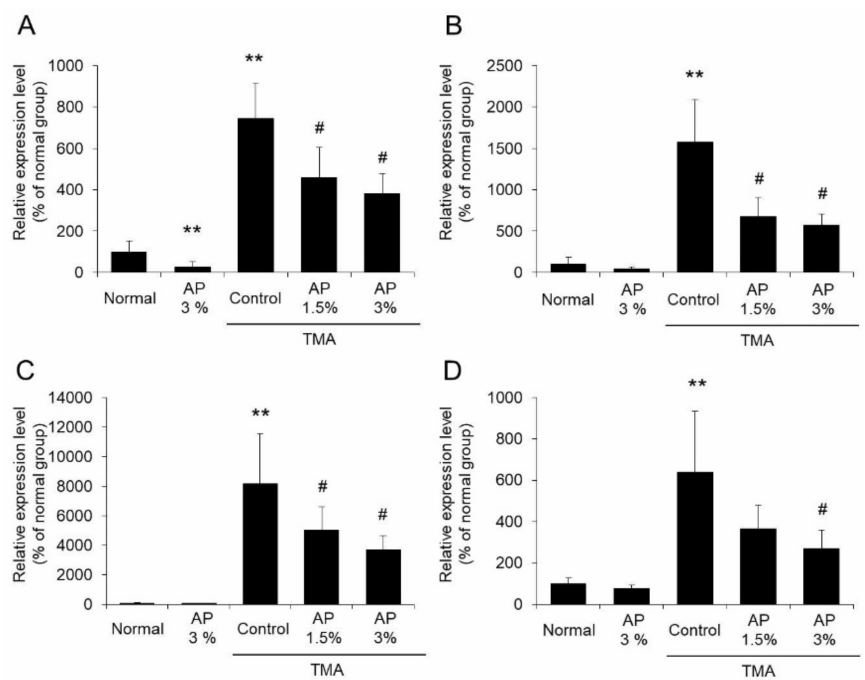
Figure 4. The mRNA expression levels of TNF- α ( A ), IL-6 ( B ), iNOS ( C ), and COX-2 ( D ). Mice with atopic dermatitis induced by repeated application of TMA were given a diet with AP. The skin was harvested, and the TNF- α ( A ), IL-6 ( B ), iNOS ( C ), and COX-2 ( D ) mRNA expression levels were measured using real-time RT-PCR (mean ± SD, N = 8, ** p < 0.01 vs. normal group, # p < 0.05 vs. TMA-control